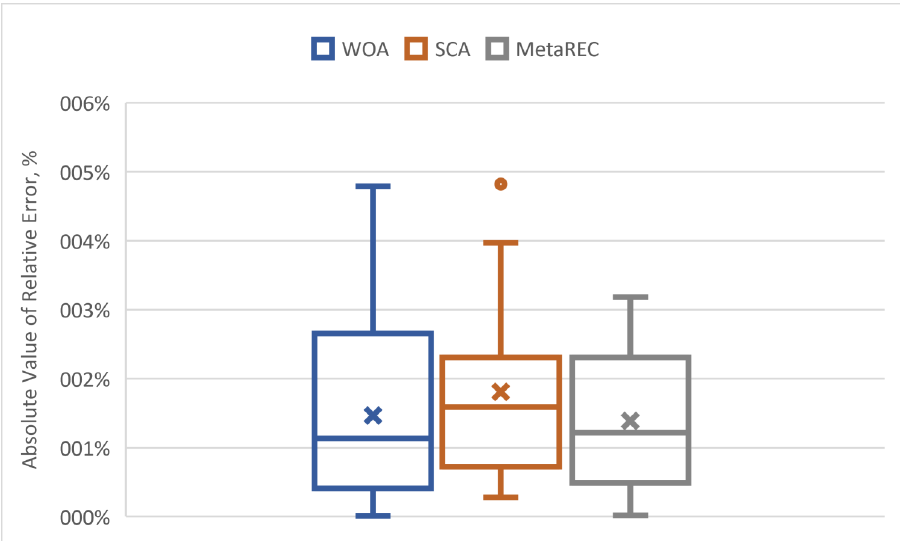
Figure 11. Minimum and maximum errors, mean (marked with cross), the first quartile, the median error, and the third quartile of absolute values of errors for the three methods.